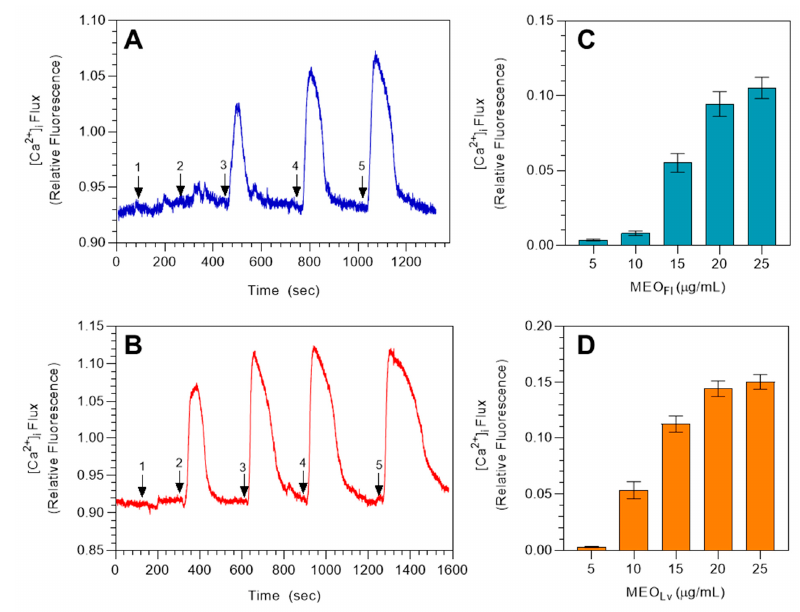
Figure 1. Monarda essential oils increase [Ca 2+ ] i in HEK transient receptor potential TRPA1 cells. Original representative traces demonstrating the dose-dependent effects of flower essential oil (MEO Fl ) ( A ) and leaf essential oil (MEO Lv ) ( B ). Arrows indicate the effects of 5 (#1), 10 (#2), 15 (#3), 20 (#4), and 25 (#5) µg/mL of the oils on [Ca 2+ ] i in HEK rTRPA1 cells. Summarized data for the dose-